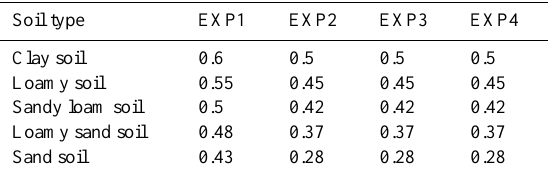
Fig. 8. Threshold friction velocity in ms − 1 calculated by MaB95, incorporating the soil moisture effect in accordance with: (a) F´ecan at al. (1999) and (b) adapted F´ecan formulation (Eq. 7).